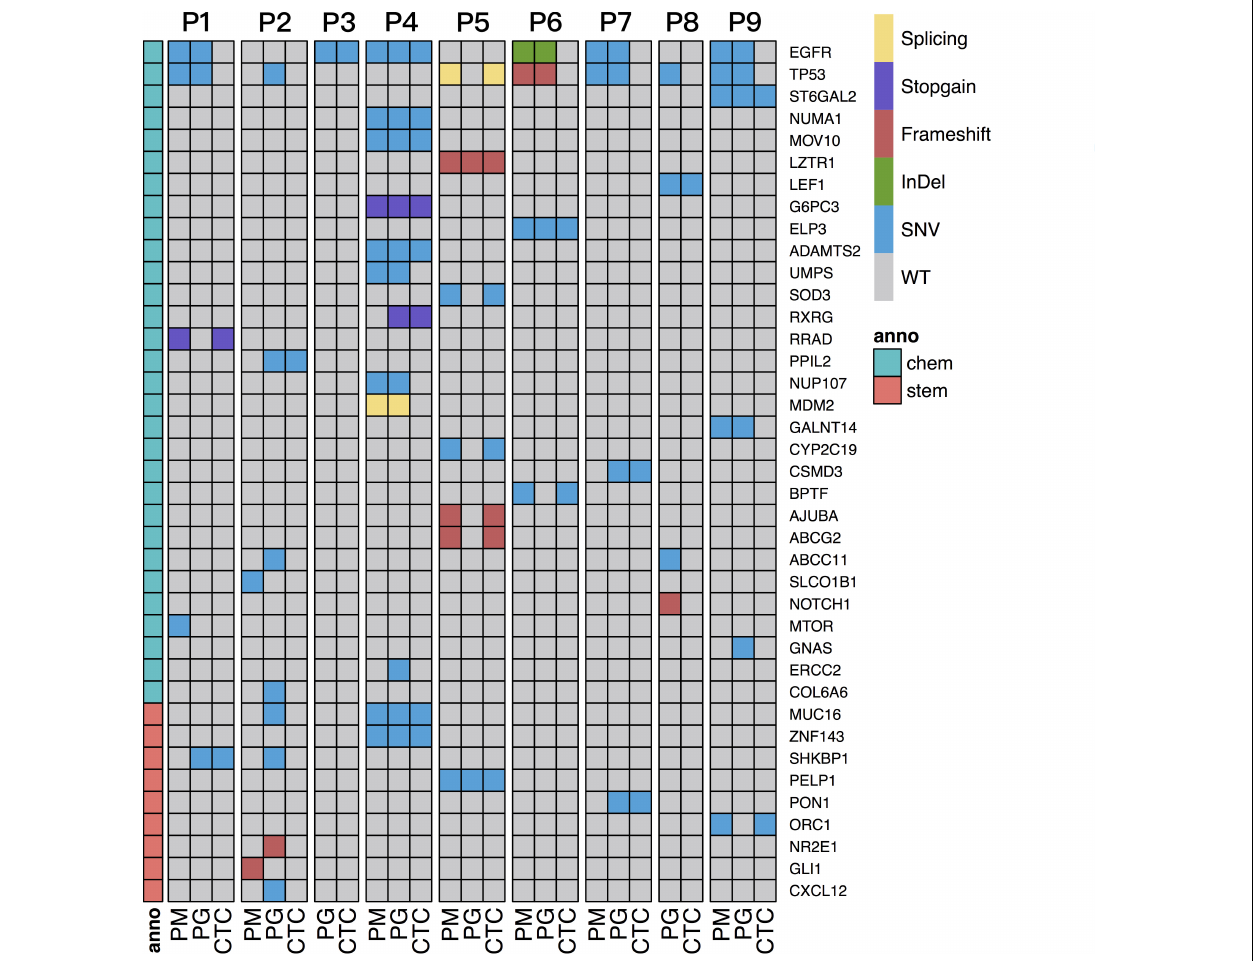
FIGURE 4 | Screening of SNVs/Indels related to chemotherapy and stem cell features shared with PM and/or PG and CTC specimens of all the patients. The gray region represents wild-type. The blank denotes no sequencing reads covered. Sample types are shown on the bottom, and patient IDs are shown on the top of the graph. Mutation genes are listed on the right. The dark blue region represents mutation genes. Chemo denotes chemotherapy-related genes, and stem denotes stem cell feature–related genes, anno denotes annotation, shown on the left